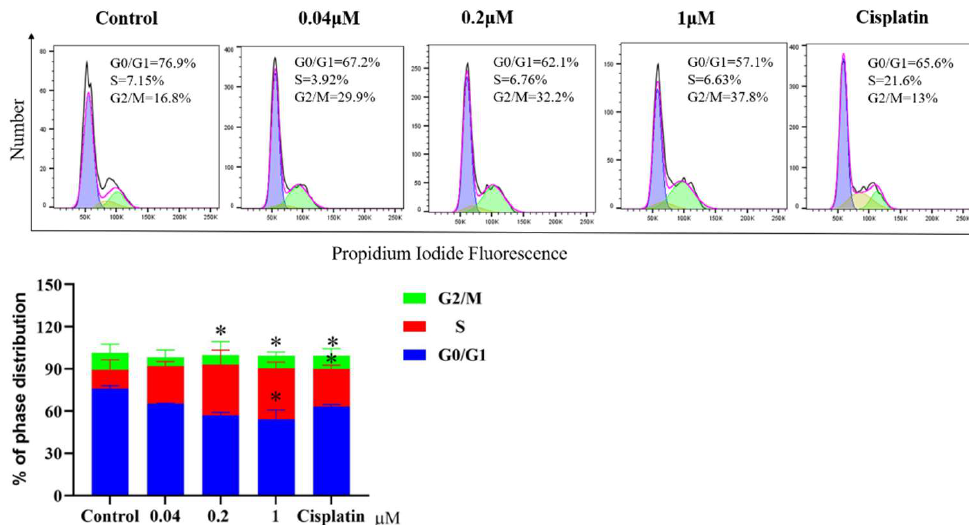
Figure 3. The cell cycle phase of A375 cells affected by CHJ04022R was analyzed by flow cytometry. All data were expressed as the mean ± SEM. * p < 0.05 compared to the control group.